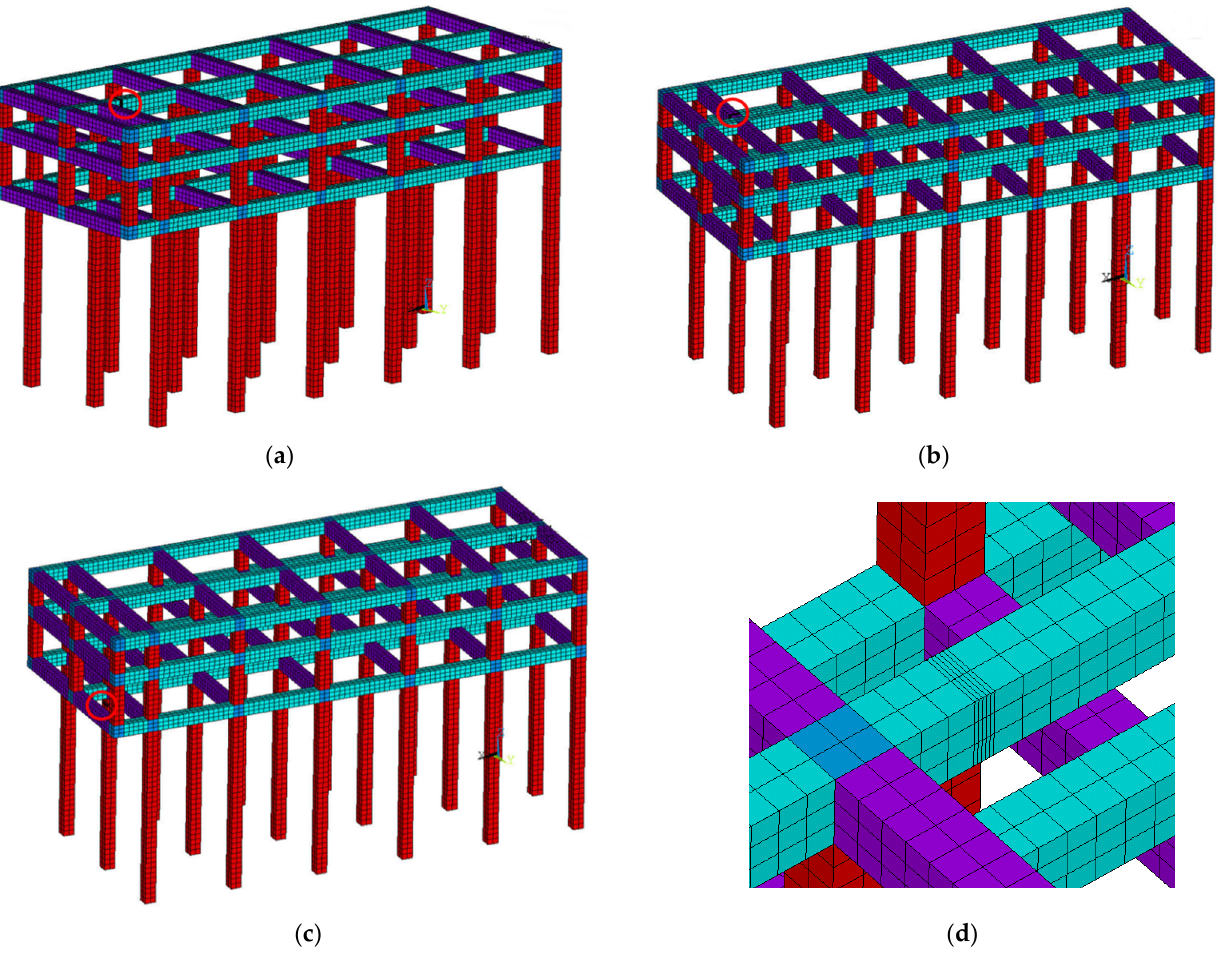
Figure 2. Finite element model of damaged wharf frame structure. ( a ) Damaged wharf frame structure near the node on the longitudinal beam. ( b ) Damaged wharf frame structure near the joint on the crossbeam. ( c ) Damaged wharf frame structure near nodes on piles. ( d ) Partial enlarged view of damaged section.